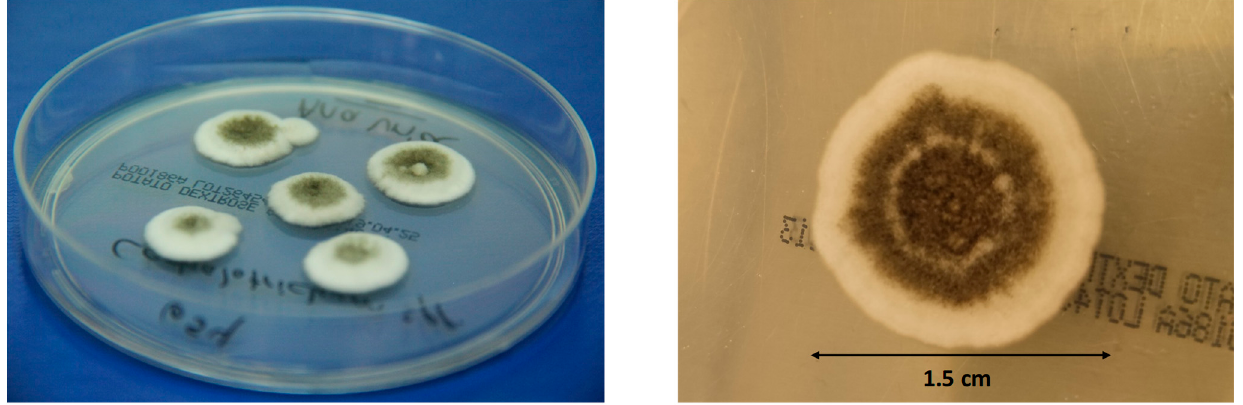
Figure 2. Cephalotrichum gorgonifer on potato dextrose agar plates after 10 days of incubation at 35 °C.